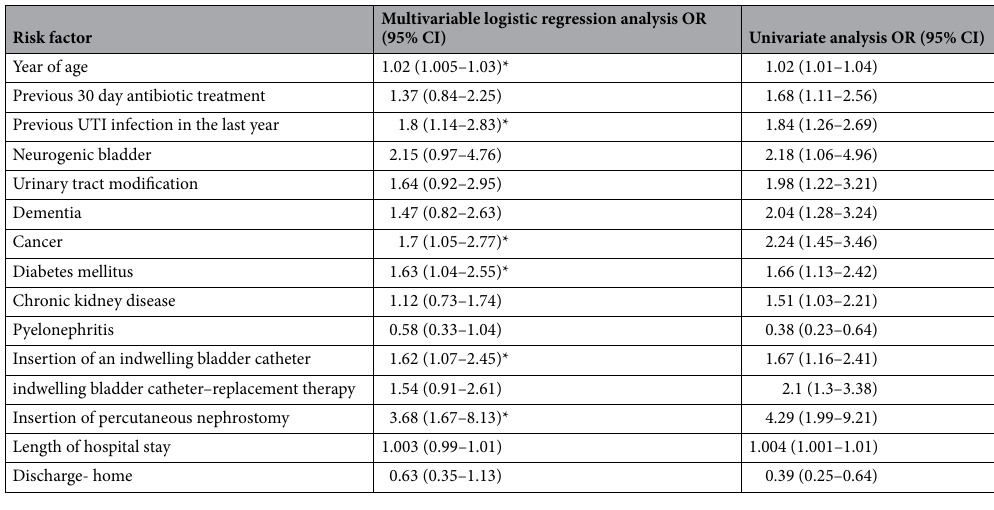
Table 4. Multivariable analysis for 60-day readmission. Risk factors for 60-day readmission, univariate and multivariate logistic regression analysis, goodness of fit -Quasi likelihood under independence model